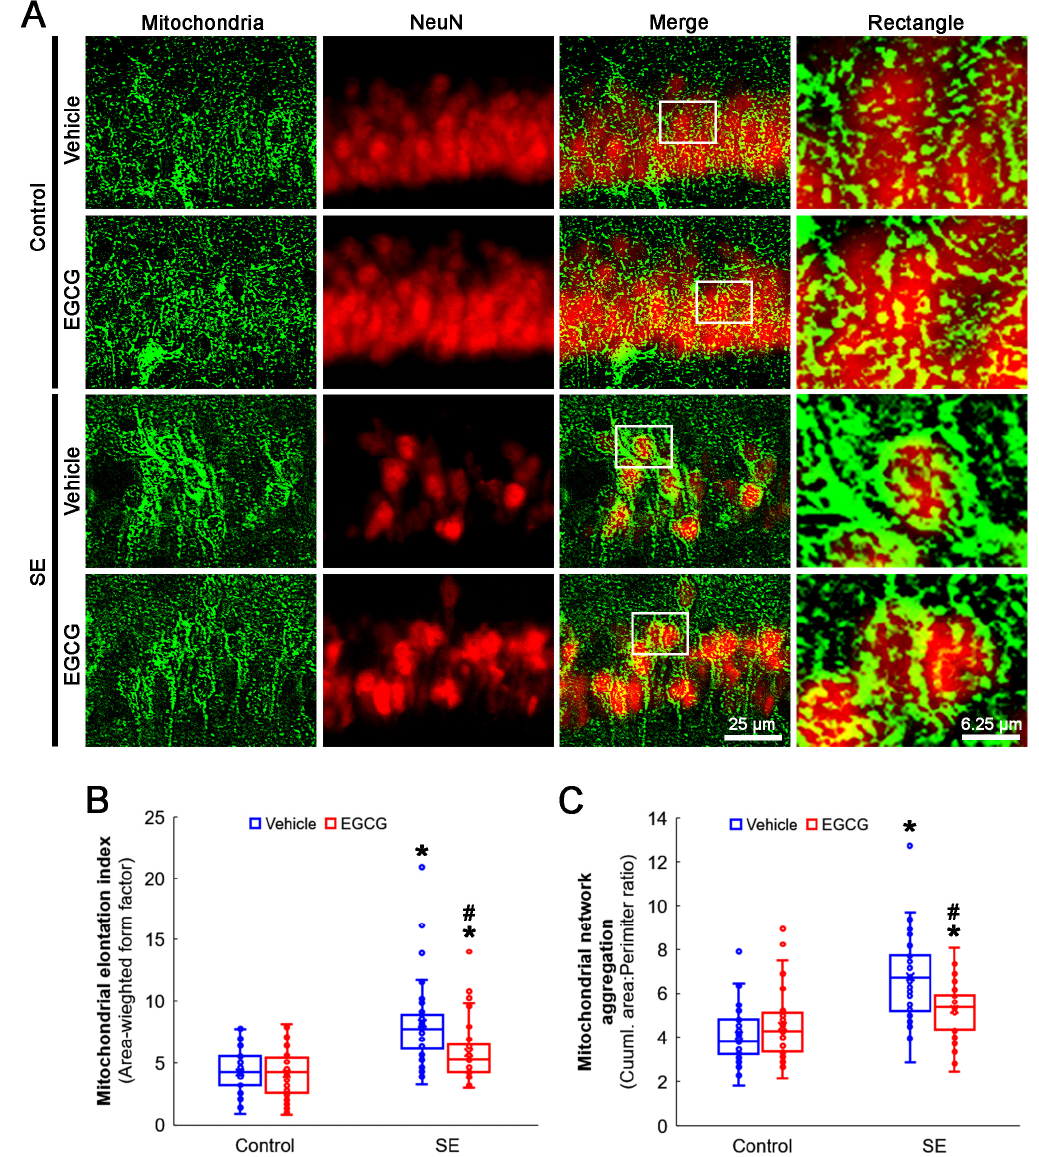
Figure 4. Effects of EGCG on mitochondrial dynamics in CA1 neurons following SE. Compared with control animals, mitochondria showed swollen, elongated and complex shapes in SE group. Mitochondria were also transformed into a reticular network or an aggregation of interconnected mitochondria in the CA1 neurons in SE group. In control animals, EGCG did not affect mitochondrial shapes in CA1 neurons, compared with vehicle-treated animals. However, EGCG attenuated SE-induced morphological changes in mitochondria. ( A ) Representative photos of mitochondria and CA1 neurons (NeuN, a neuronal marker). Rectangle indicates the high-magni fi cation photos in